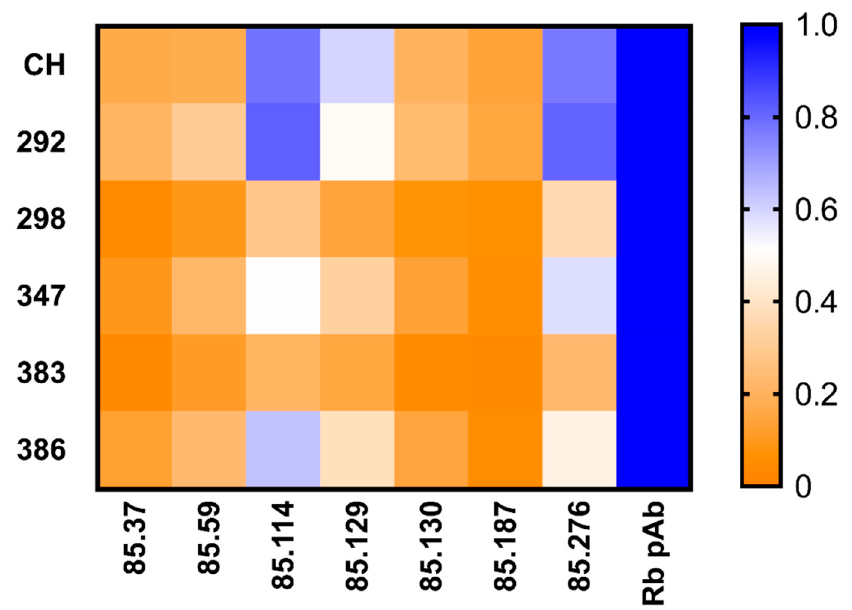
Figure 6. Mutations in surface exposed regions of GII.2 Chapel Hill show variation in mAb recognition: One site specific binding curves were fit to find the maximum binding, Bmax, values of GII.2 derived mouse mAb binding to GII.2 Chapel Hill alanine mutated VLPs, and normalized across VLP to the rabbit polyclonal sera Bmax value with proportion high to low (blue to